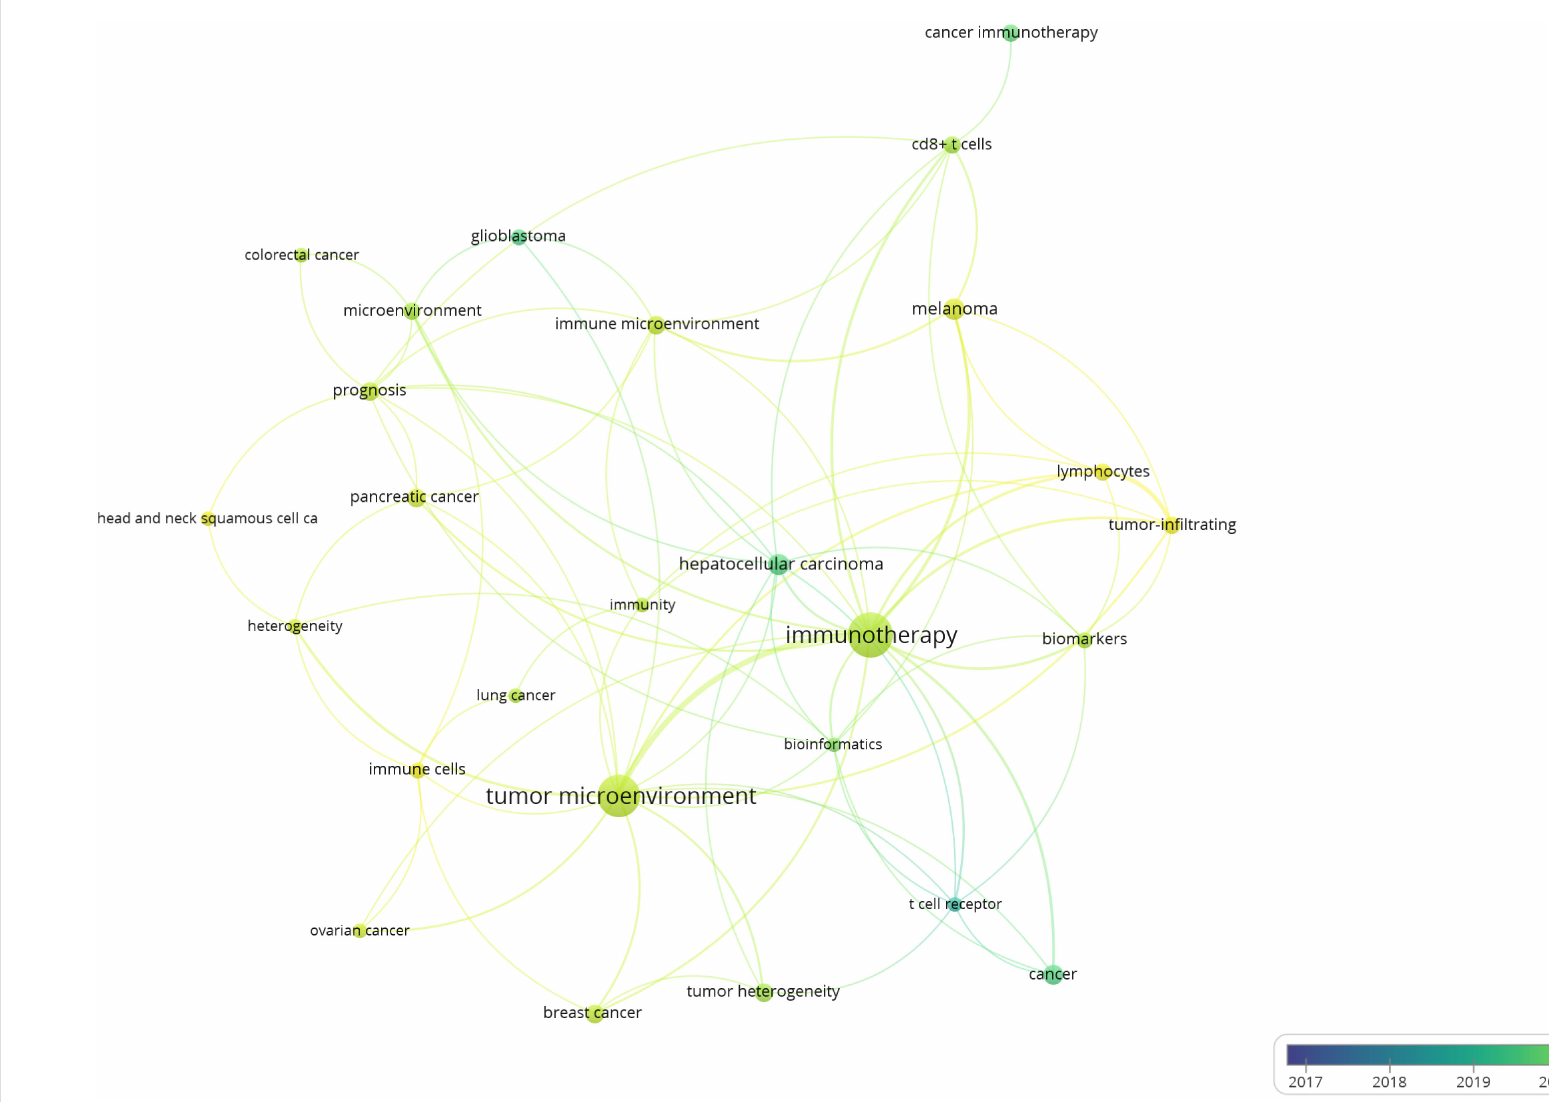
FIGURE 7 The author keyword co-occurrence overlay visualization maps of single-cell sequencing publications in cancer biology on T cell research. The circle size represents the frequency of use of the speci fi ed author keywords. The co-occurrence link is represented by the circle distance, and the strength of the link is indicated by the thickness of the connecting line. Circle color denotes the average publication